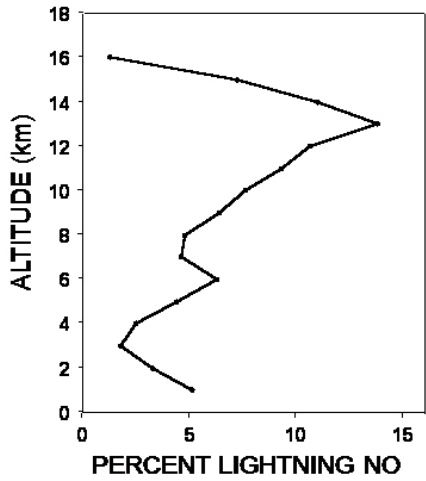
Fig. A2. Vertical allocation of lightning NO emissions based on modified Pickering et al. (1998) mid-latitude continental profile. Modifications were made as suggested by L. Ott (personal communication, 2007) to eliminate the large peak in the lowest kilometer in the Pickering et al. (1998) profile.